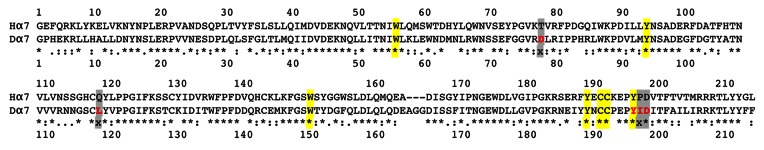
Sequence alignment of ligand-binding domain of Dα7 with Human α7 nAChR subunit.There is a 48% amino acid identity of the entire subunit sequences. Within the ligand-binding domain, there is an 81% amino acid homology, with a 58% amino acid identity. Key residues for agonist binding are highlighted in yellow and mutated residues are in red. An * (asterisk) below residue alignment denotes positions that have a identical residues. A colon denotes groups with strongly similar properties and a scoring of >0.5 in the Gonnet PAM 250 matrix. A period denotes groups with weakly similar properties and a scoring of ≤0.5 in the Gonnet PAM 250 matrix [28].